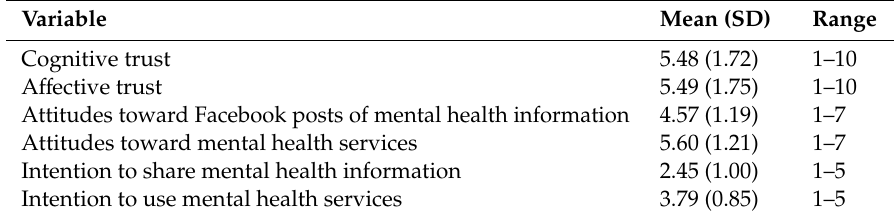
Table 1. Descriptive Statistics of Main Variables under Study.